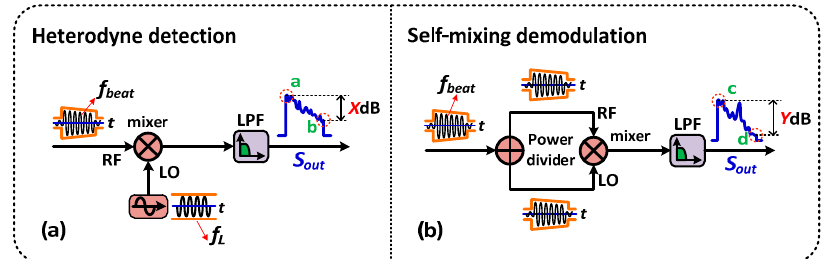
Figure 7. The comparison between the heterodyne detection and the self-mixing method on the maximum sensing distance. ( a ) The heterodyne detection and ( b ) the self-mixing